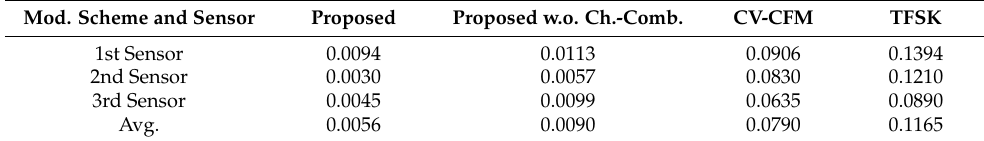
Table 4. BER results of the ocean